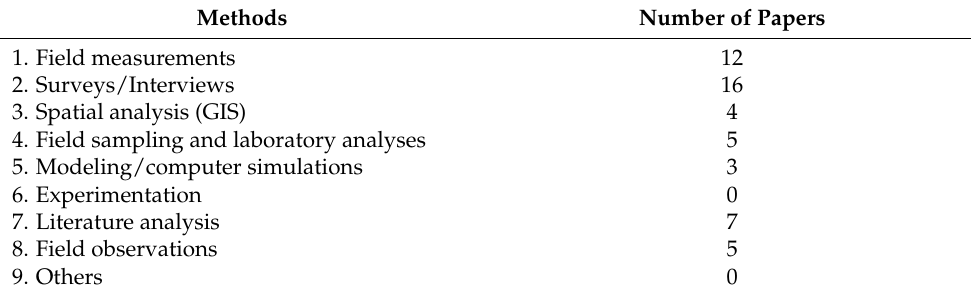
Table 1. Distribution of articles based on research methods.